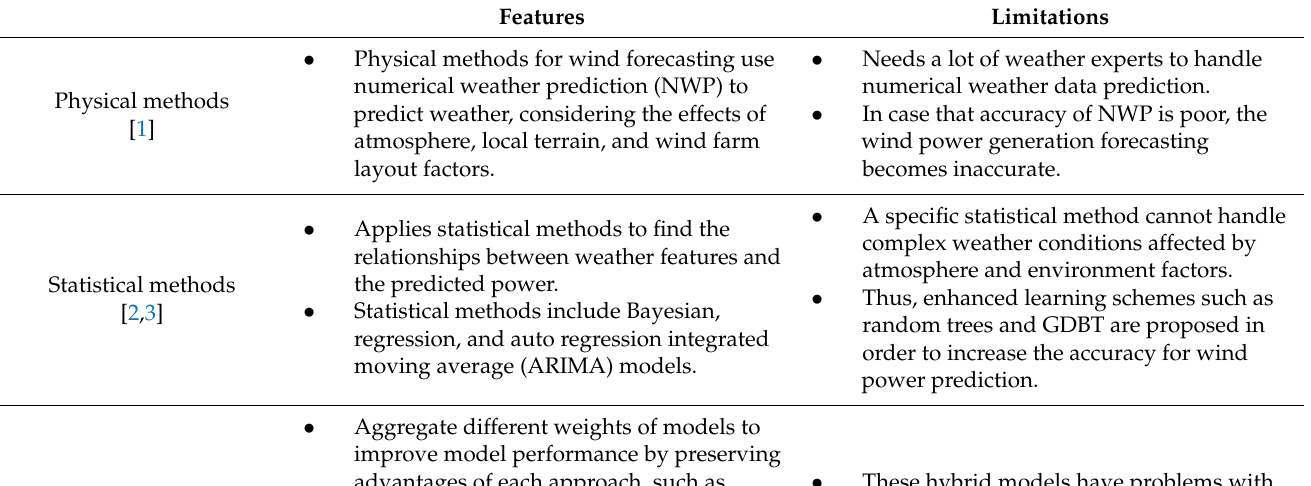
Table 1. Four Major Approaches for Wind Power